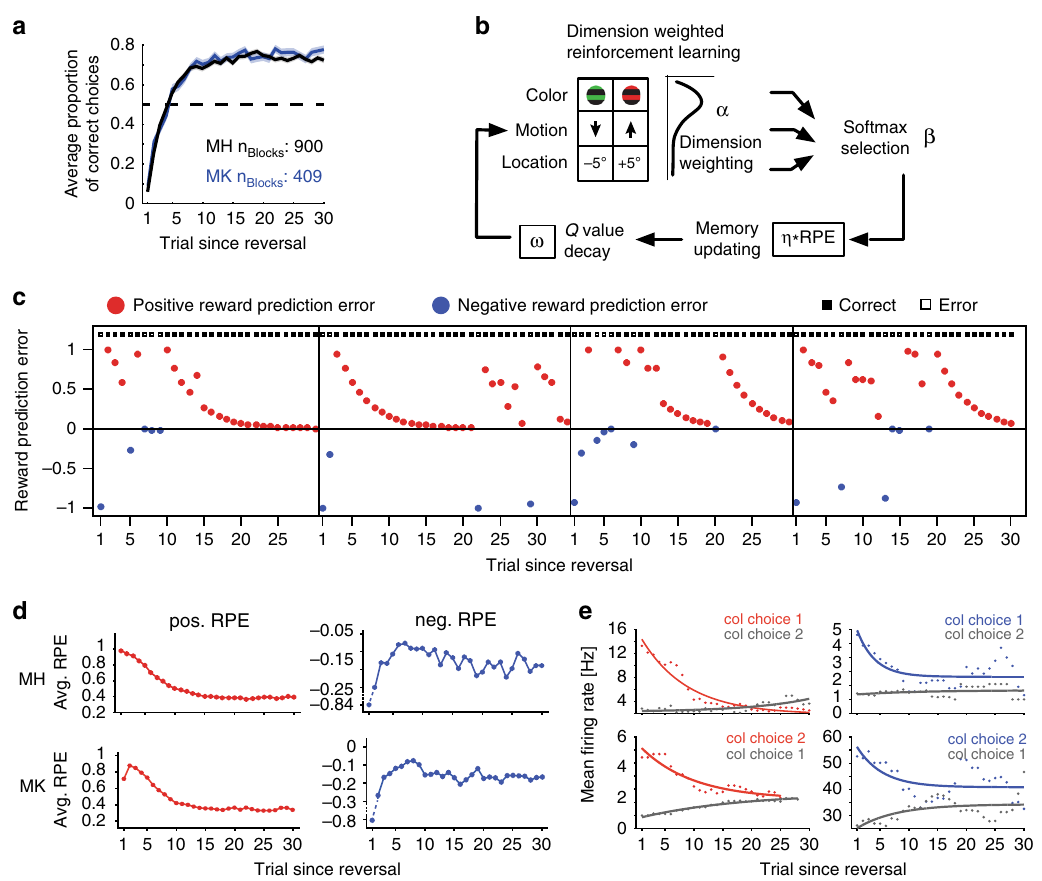
Fig. 2 Task performance and reinforcement learning model-derived RPEs. a Average proportion of correct choices relative to the reversal for monkey H (gray) and monkey K (blue). Shaded error bars represent standard error of the mean (SEM). Numbers of blocks included in the analysis are indicated for both monkeys. b Dimension weighted reinforcement learning model with main parameters alpha, beta, omega, and eta ( α , β , ω , and η ) for feature weighting, selection noise, decay rate, and learning rate, respectively. c Model-derived reward prediction errors for four example reversal blocks. Positive RPEs are indicated in red, negative RPEs are indicated in blue. Small black fi lled and white fi lled squares at the top of each graph indicate correct and error choices, respectively. d Average positive (left) and negative (right) model-derived RPEs across the fi rst 30 trials of a reversal block for monkey H (top) and monkey K (bottom). e Average fi ring rates of four example neurons in the outcome epoch following color 1 and color 2 choices across trials in a reversal block, in correct trials (left two neurons) and in error trials (right two neurons). These neurons were later identi fi ed to encode color-speci fi c positive and negative RPEs, respectively. For visualization purposes only, exponential functions were fi t to the data